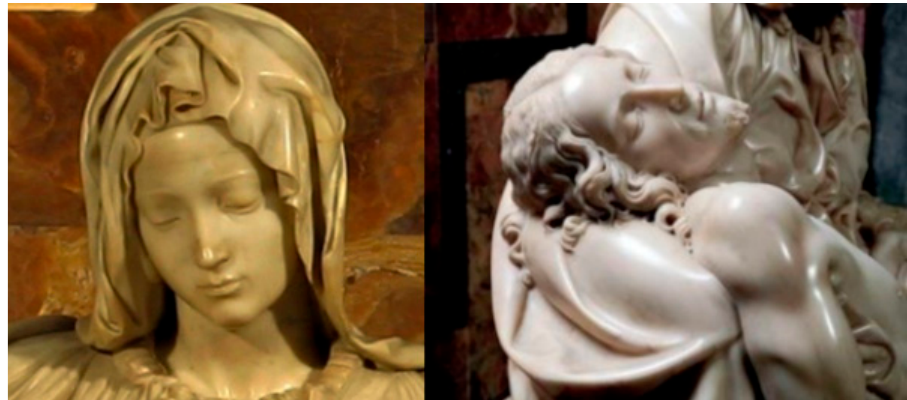
Figure 8. How old is this woman? How old is this man? After Michelangelo’s Pietá, Saint Peter’s Basilica. A close-up view of two sections.